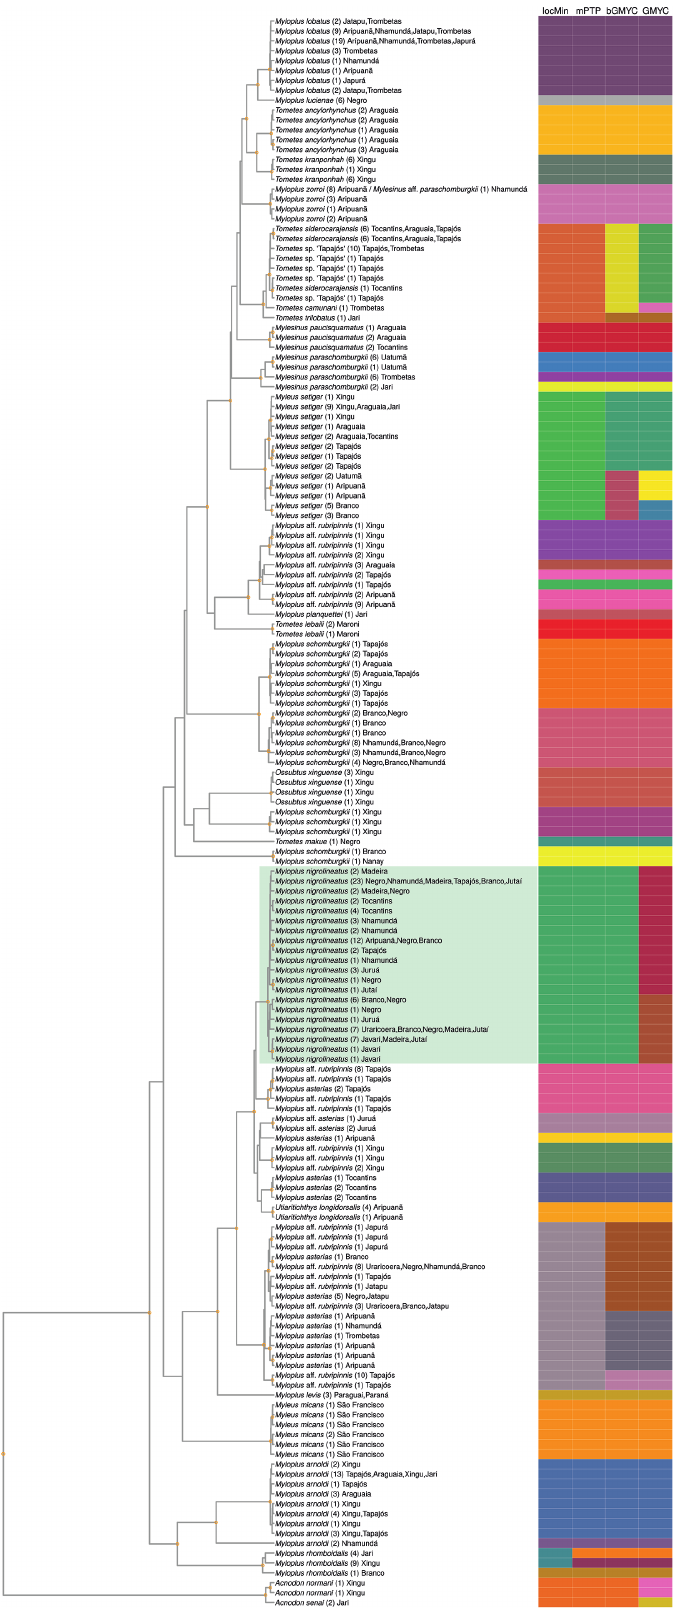
FIGURE 6 | Chronogram (maximum clade credibility consensus of 3,000 post burn-in posterior trees) of Myloplus and related genera constructed in BEAST using DNA barcode sequence data. Comprises 161 unique haplotypes (total 406 sequences), with the number of haplotypes represented by each tip in parentheses, followed by the drainages where these haplotypes were recovered. Species discovery congruence for four methods (localMinima, mPTP, bGMYC and GMYC) is presented in colored columns. Branch support (Bayesian posterior probability) of ≥95% is shown with an orange node label. Myloplus nigrolineatus is highlighted with a green